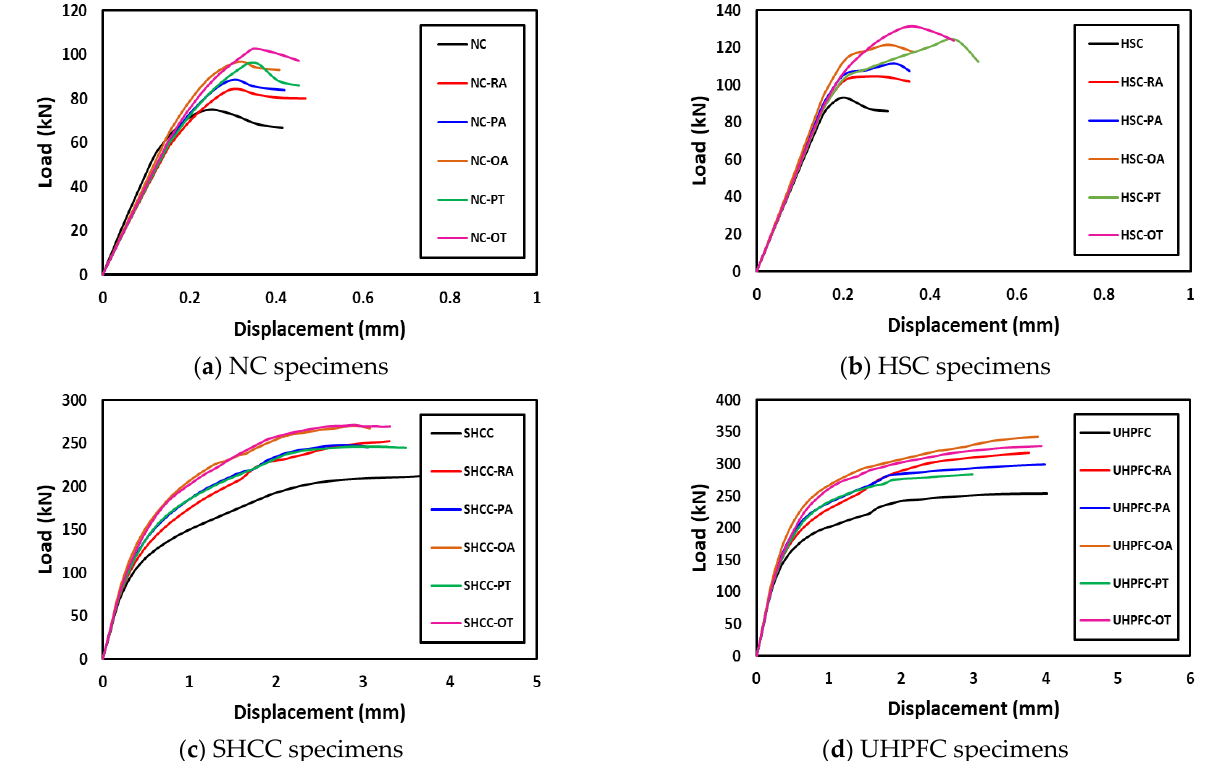
Figure 11. Load – displacement curves for tested specimens. Figure 11. Load–displacement curves for tested